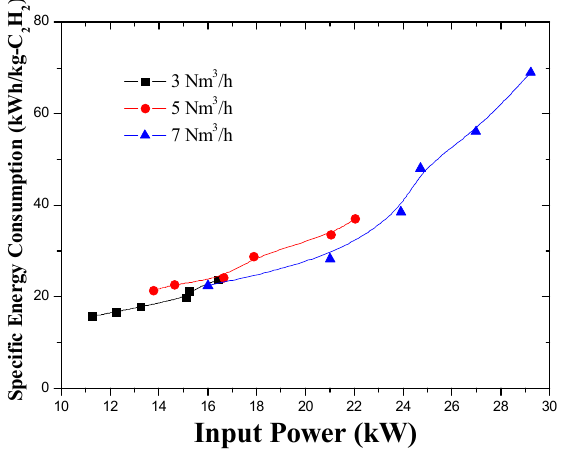
Figure 9. Variation in the specific energy consumption ( SEC ) of C 2 H 2 at working gas flow rate of 3 Nm 3 /h, 5 Nm 3 /h, 7 Nm 3 /h (Carrier gas flow rate: 1 Nm 3 /h; feed rate: 17.65 g/min; magnetic flux intensity: 0.077 T).